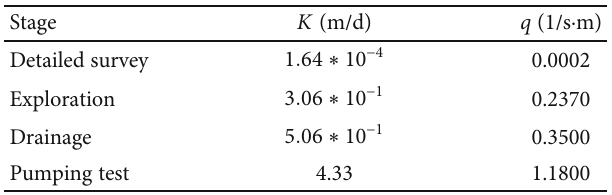
Figure 1: The locality of the study area. Table 1: Variation of hydrogeological parameters of weakly cemented